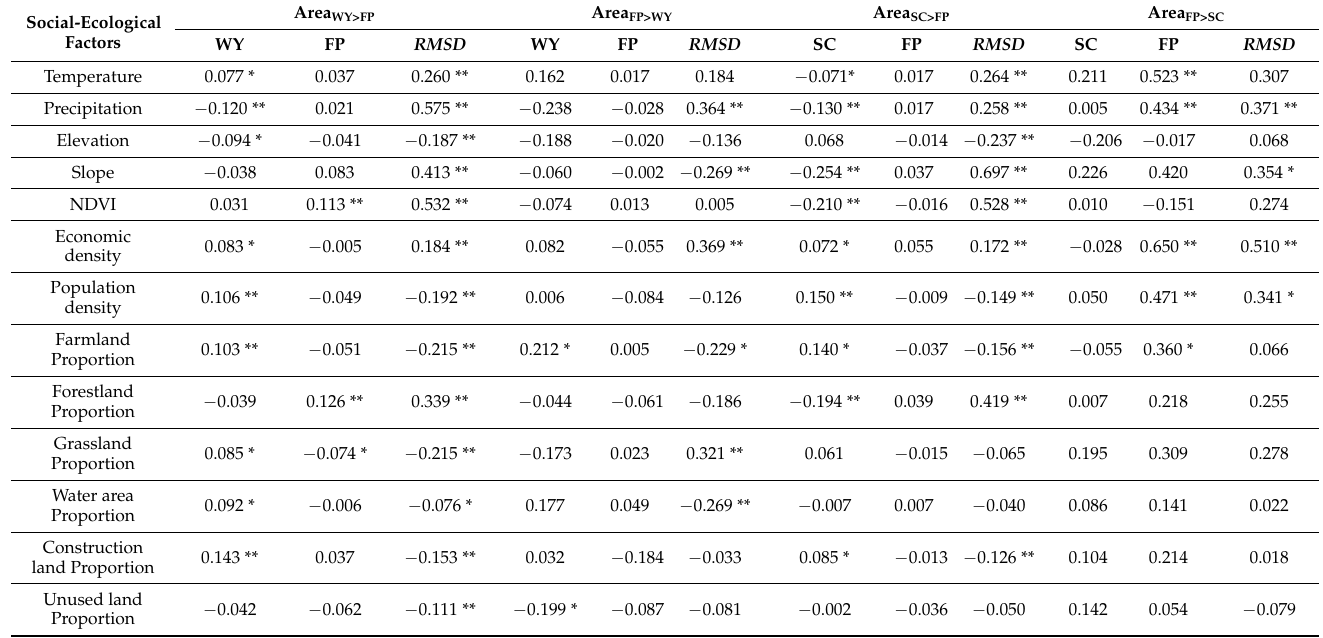
Table 4. Effects of factors on trade-offs and supply–demand